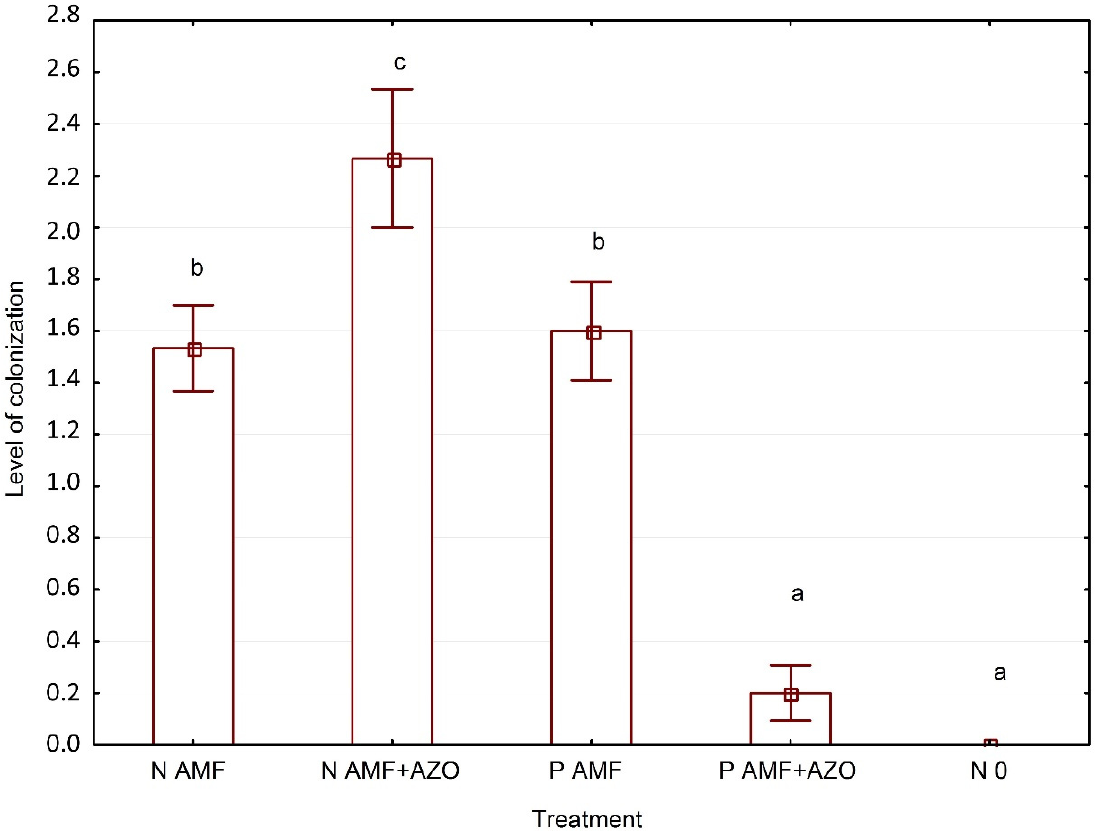
Figure 4. Means ( ± SE) of AMF colonization evaluation, separated into homogenous groups (a, b and c) according to Fisher’s LSD test. Explanatory notes: N AMF-ToBRFV negative plants treated with arbuscular mycorrhizal fungus, N AMF + AZO-ToBRFV negative plants treated with AMF and Azospirillum , P AMF-ToBRFV positive plants treated with arbuscular mycorrhizal fungus, P AMF + AZO-ToBRFV positive plants treated with AMF and Azospirillum , N 0—negative non-treated plants.